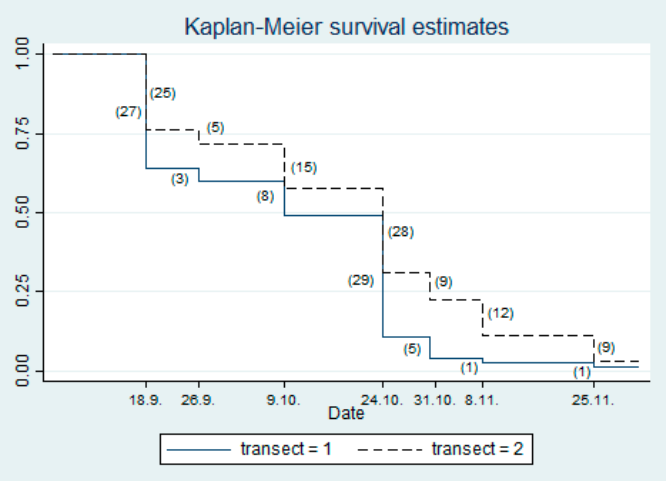
Figure 6. Kaplan–Meier survival estimates. Table 2. Number of dead noble pen shells found along the transects from the setup of the pilot study (4 September 2019) until its completion (25 November